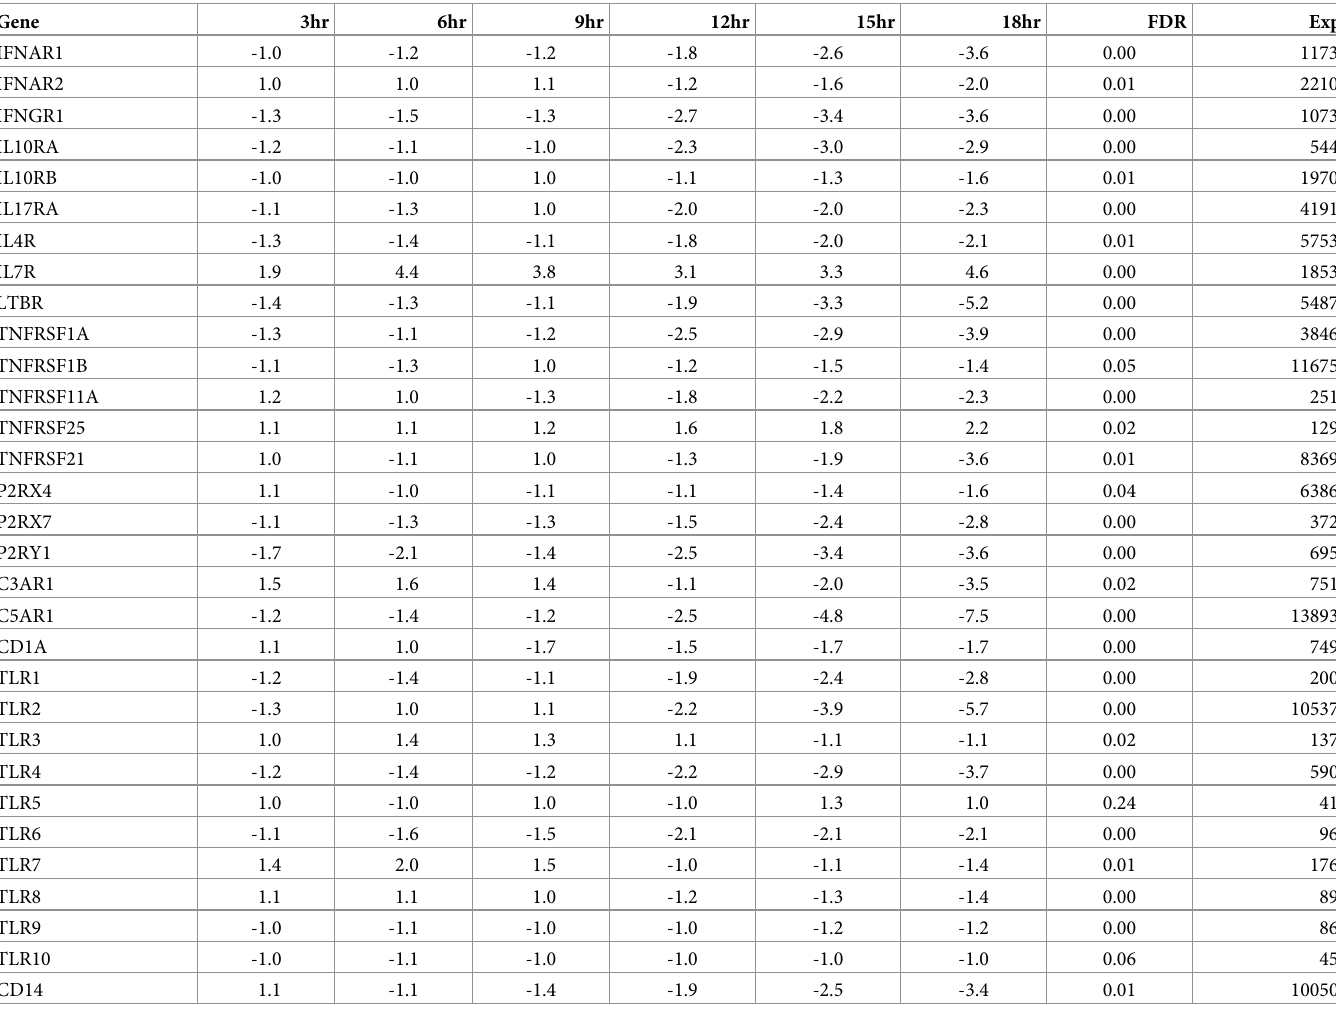
Table 6. Differential expression (fold = infected/non-infected) with a FDR less than 0.05 at one or more time points and the averaged expression level (Exp) of cell receptor genes between infected and non-infected macrophages at 3, 6, 9, 12, 15 and 18 hours post